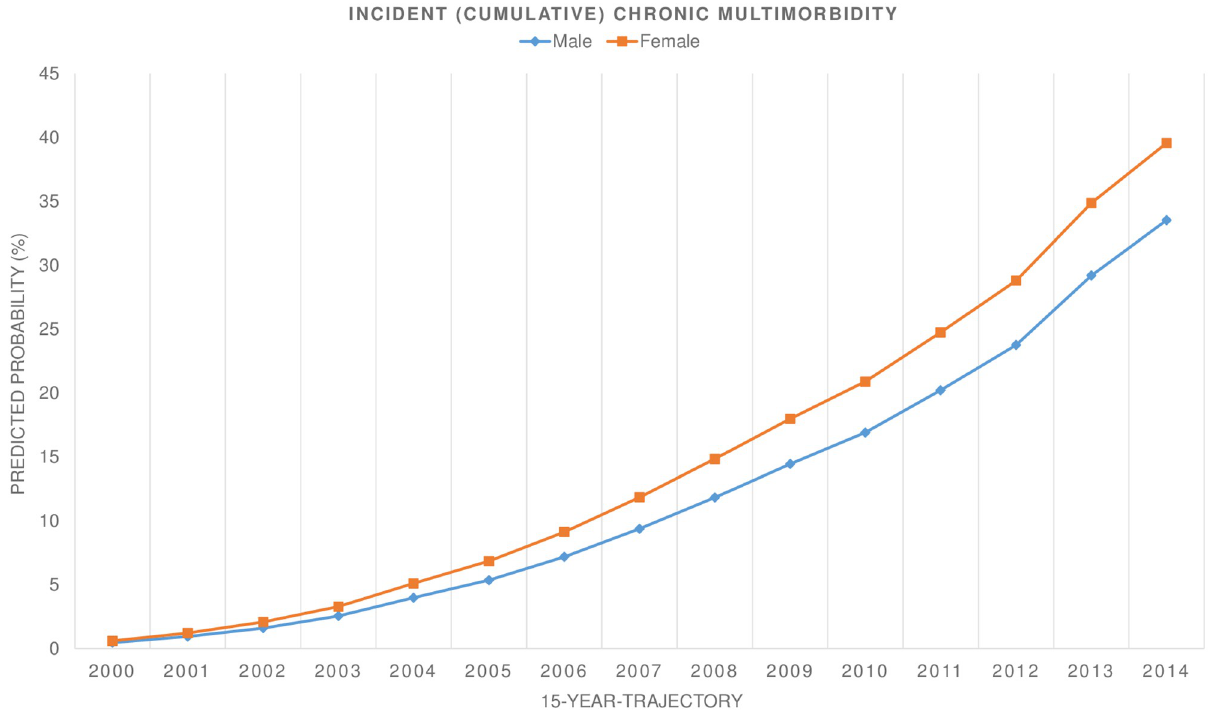
Fig 1. Incident (cumulative) multimorbidity (%) during 15-year trajectory stratified by sex.